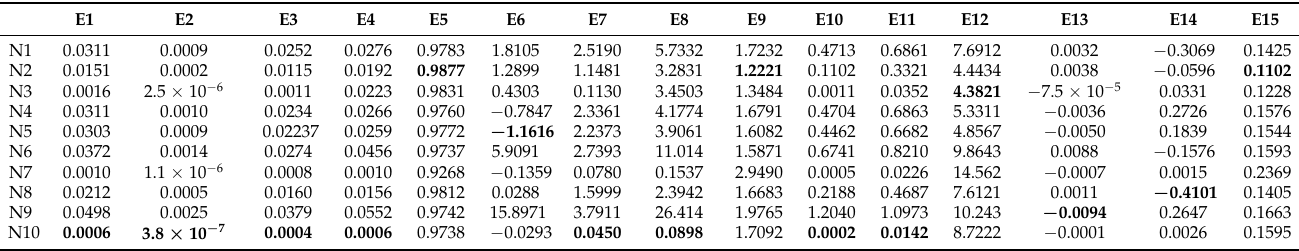
Table 7. Error values in testing Legendre network for Bitfinex dataset.